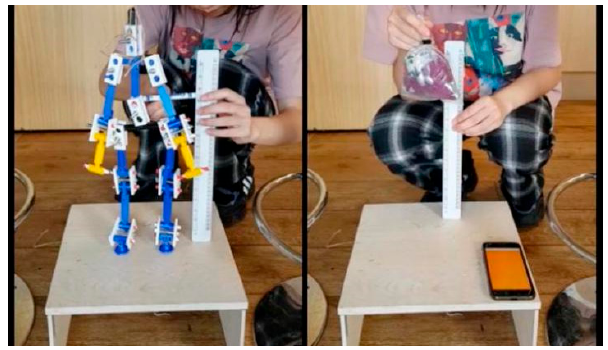
Figure 8. The experiment of object drops.